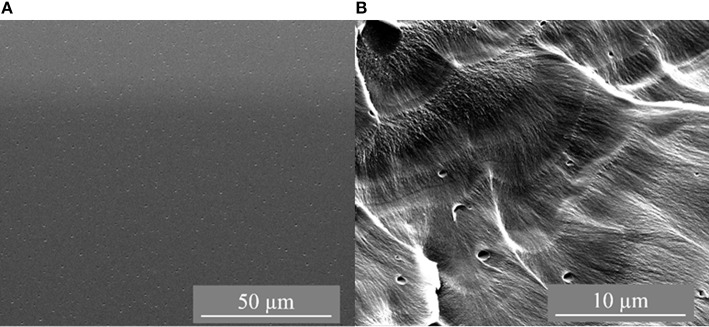
SEM images of pure PSF membrane [(A): top side view; (B): cross section view].